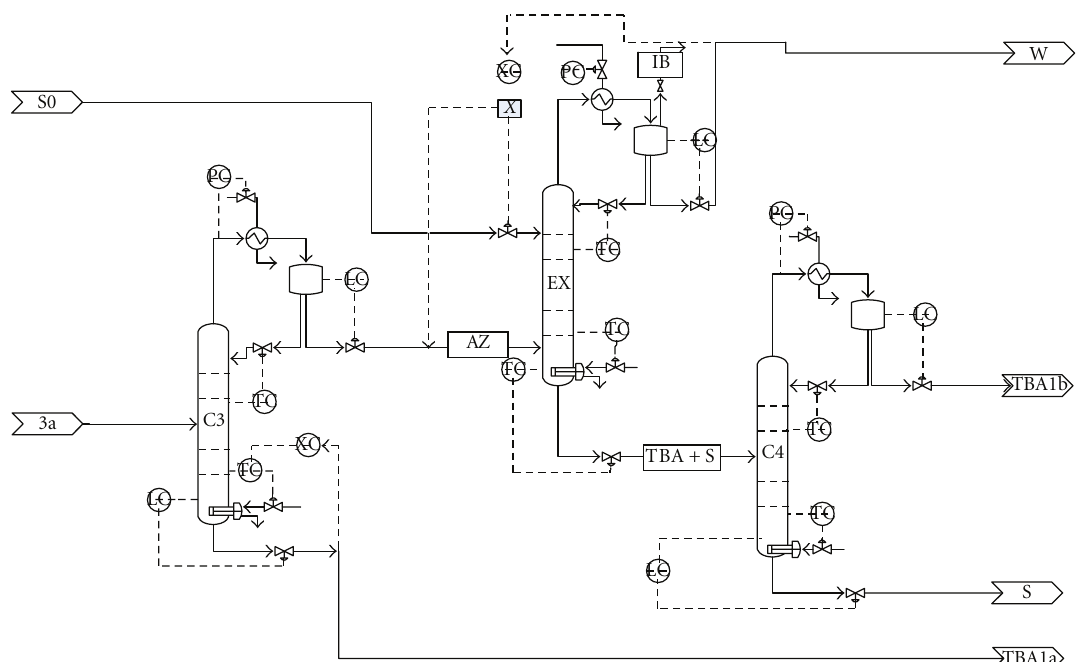
Figure 8: Flowsheet and control loops of the azeotrope separation